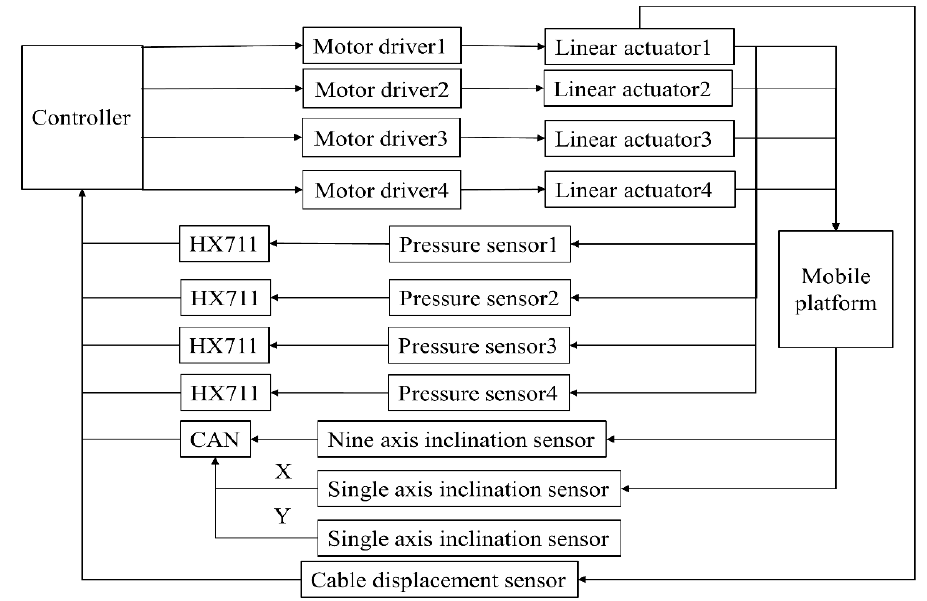
Figure 2. Working principle diagram of